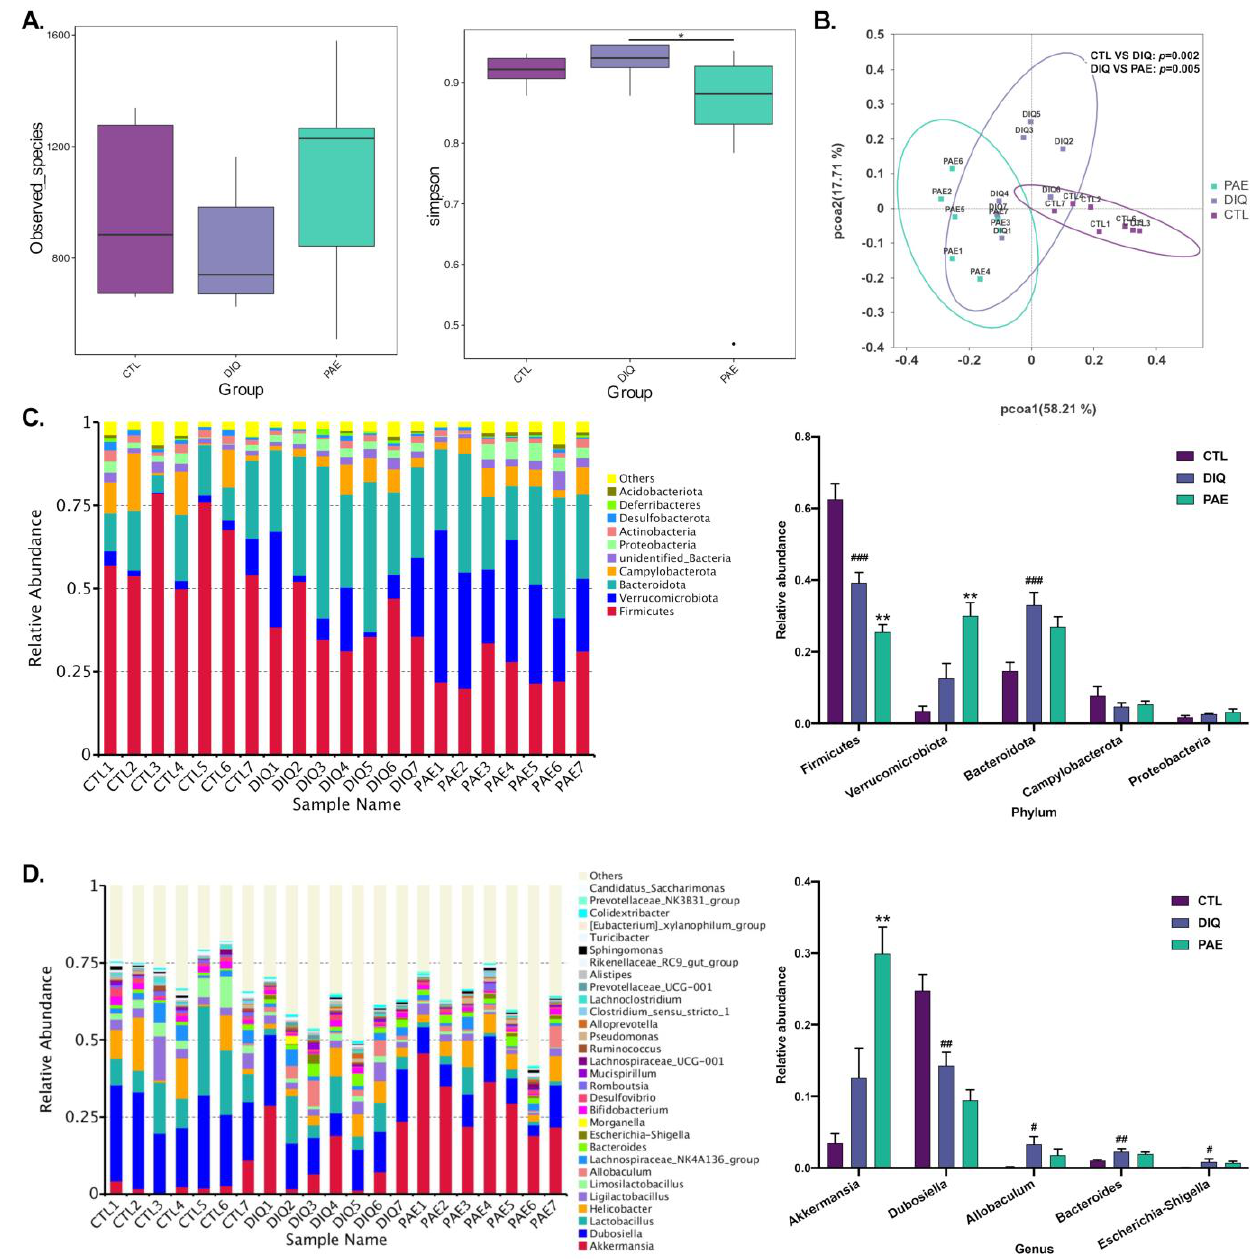
Figure 6. Effects of PAE on microbial community of cecum in the diquat-treated mice: ( A ) Alpha- diversity analysis (Observed_species and Simpson’s index); ( B ) beta-diversity analysis based on weighted Unifrac (PCoA); ( C ) relative abundance of the top 10 intestinal microbiota at the phylum level; ( D ) relative abundance of the top 30 intestinal microbiota at the genus level. PAE, PAE-100 (100 mg/kg) group. All data were represented as means ± SD, n = 7. # p < 0.05, ## p < 0.01, and ### p < 0.001 as compared with the control group; * p < 0.05 and ** p < 0.01 as compared with the diquat-treated group.